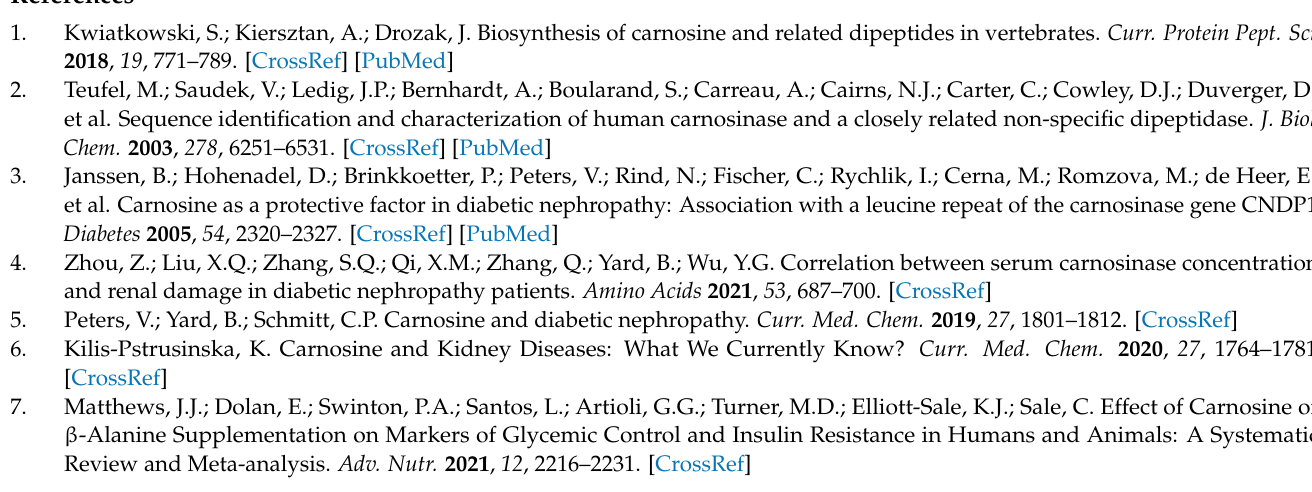
and CBS inhibitors in kidney tissue lysate of WT and Cndp1 -KO mice (47- to 51-week-old, n = 3–5); Supplementary Table S8: Renal H 2 S formation and anserine concentrations in Hsp70 -KO mice (23- to 28-week-old, n = 6–9); Supplementary Table S9: Incubation of kidney tissue lysate with anserine and carnosine (6h) did not increase renal H 2 S formation in WT mice (23- to 26-week-old, n = 3–5); Supplementary Figure S1: Homocysteine dependent H 2 S formation in human proximal tubular ep- ithelial cells (HK-2); SupplementaryFigureS2: H 2 SformationdependsonHSP70; Supplementary Figure S3: Original western blot membranes of protein expression of HSPA1A and β -ACTIN in cell clones; Supplementary Figure S4: Ex vivo renal H 2 S formation in Cndp1- KO mice; Supplementary Figure S5: Cystathionine- γ -lyase (CSE) and cystathionine- β -synthase (CBS) activity dependent kidney H 2 S formation; Supplementary Figure S6: Exogenous anserine and carnosine did not affect H 2 S